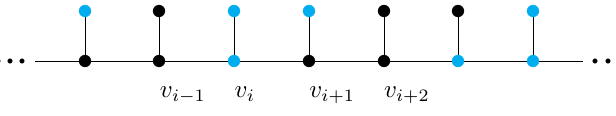
Fig. 2: Properties of the ordering